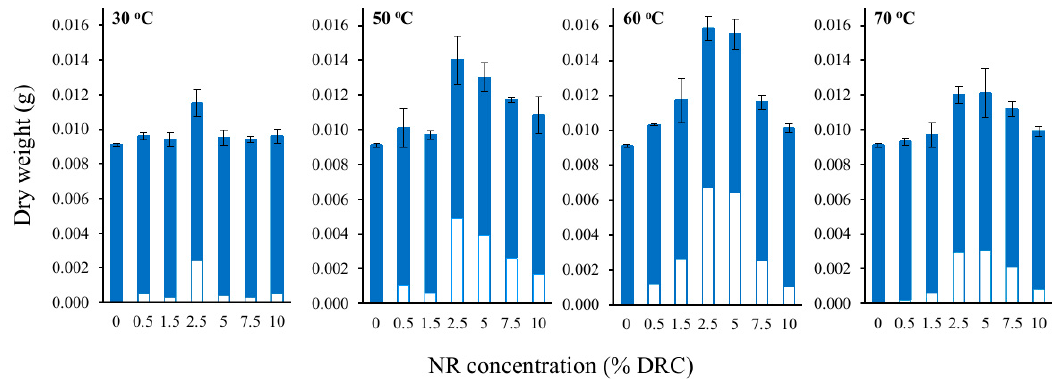
Figure 4. Dry weight of NR–BC films modified by immersing in an NRL suspension at various concentrations (0%–10% dry rubber content (DRC)) at immersion temperatures of 30 °C, 50 °C, 60 °C, and 70 °C. Values were expressed as mean ±SD ( n = 3); blue bar = the dry weights of BC before the immersion and white bar = the estimated NR dry weights in the composites. Table 1. Thickness of natural rubber (NR)–bacterial cellulose (BC) films.